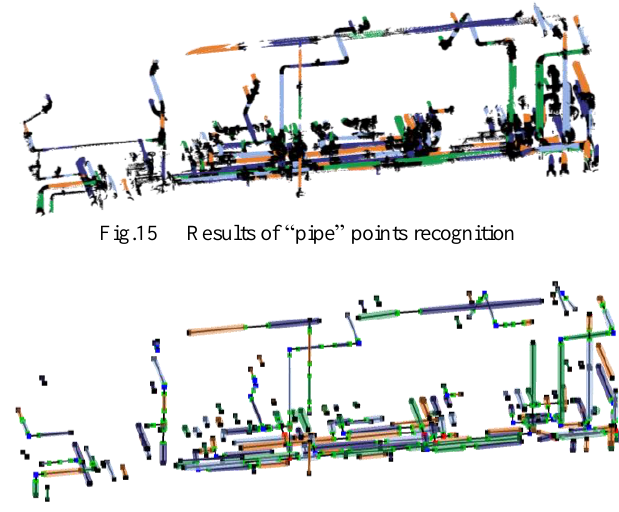
Fig.16 Results of connecting relationship